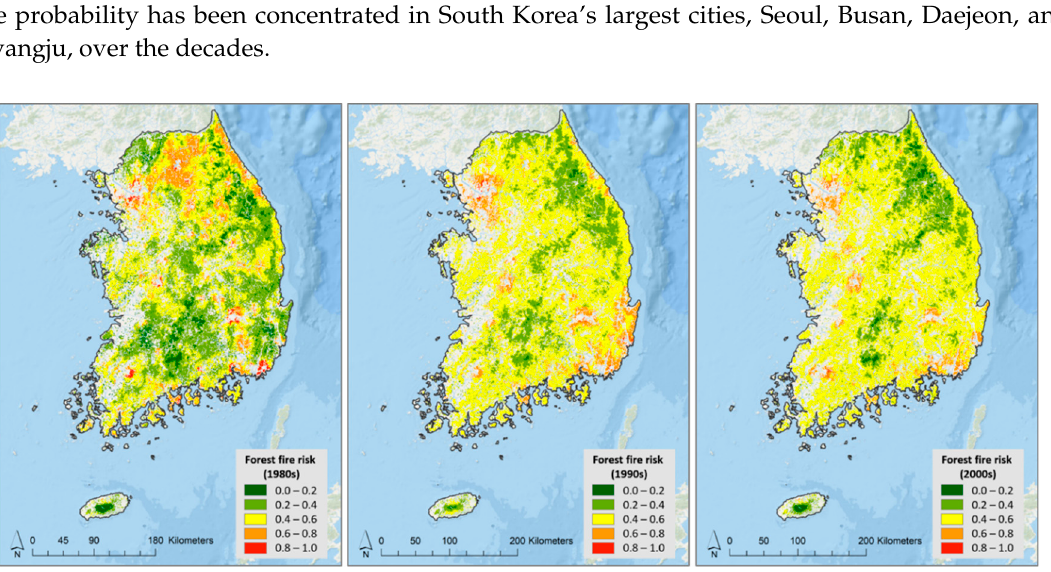
Figure 6. Forest fire probability during the 1980s, 1990s, and 2000s (Maxent analysis).